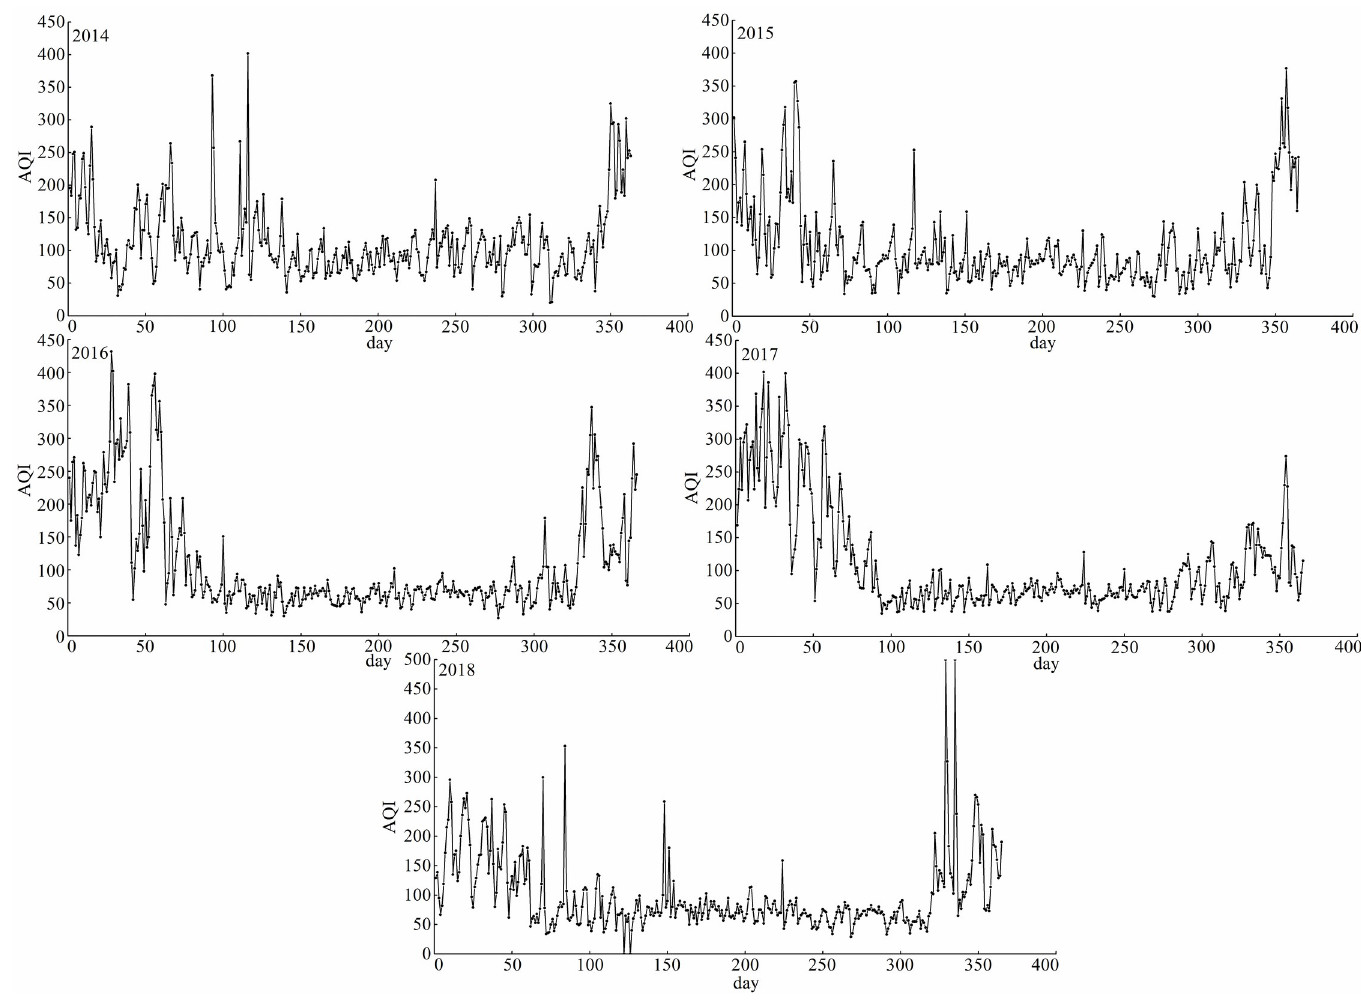
Fig 6. Daily changes of AQI in Urumqi.